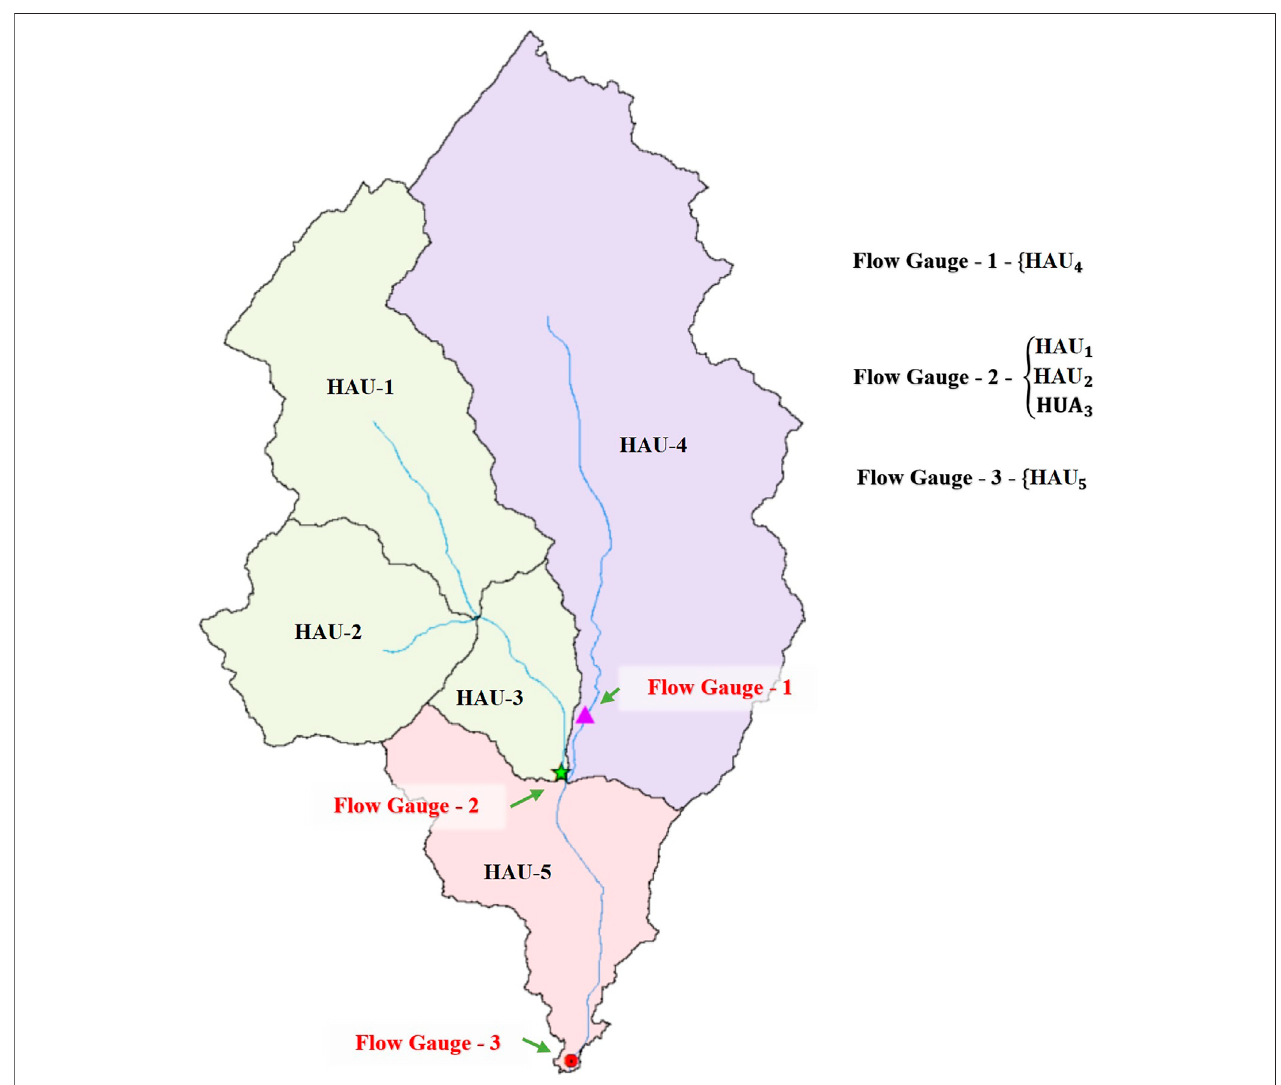
FIGURE 5 | Cumulative calibration